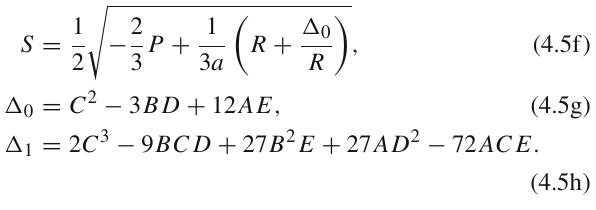
(b) Thimble, anti-thimble, and (c) Thimbles and anti-thimbles for the critical points φ ± of the ghosts for the critical point φ 0 ghosts for all the critical points, φ 0 and φ ± , of the action. of the action. action. Fig. 3 The solutions to the thimble equation given in Eq. (3.3), corre- green solid curves represent the thimbles, red dashed curves represent sponding to the critical points φ 0 and φ ± , for the parameters { a = 1, the anti-thimbles, and the grey solid curves represent the ghosts. The b = − 0 . 9, c = 0, d = 1 . 5, h = 0 } . In all the three figures, the shaded regions represent the regions where Re ( S ) ≥